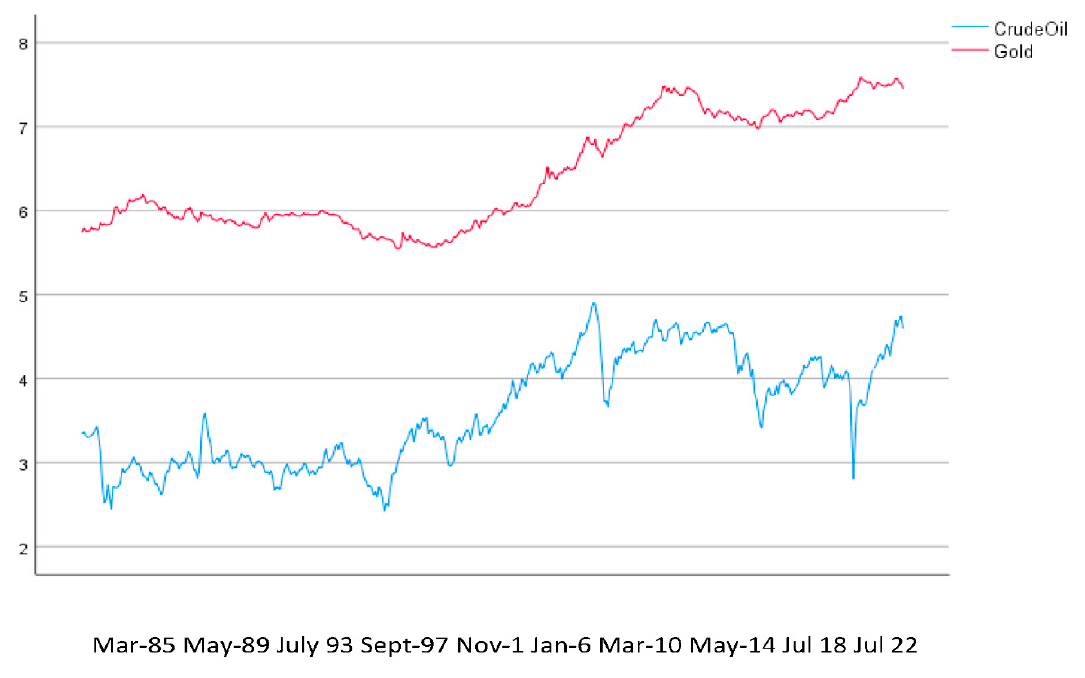
Figure 5. Time-Series (Logarithmic) Plot of Crude Oil and Gold Price Patterns. Proposition 6. There is a positive relationship between oil and wheat